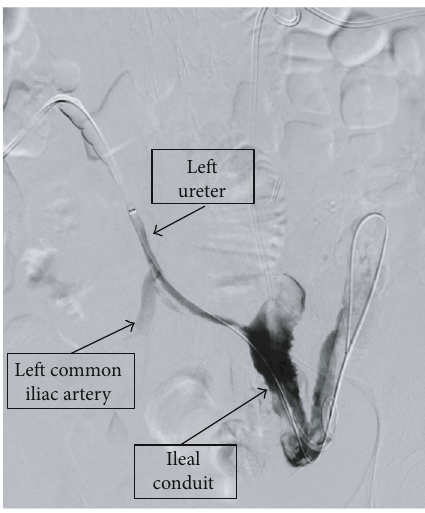
Figure 1: Left nephrostogram with contrast noted extravasating through the fi stula tract from the left ureter into the left iliac artery.